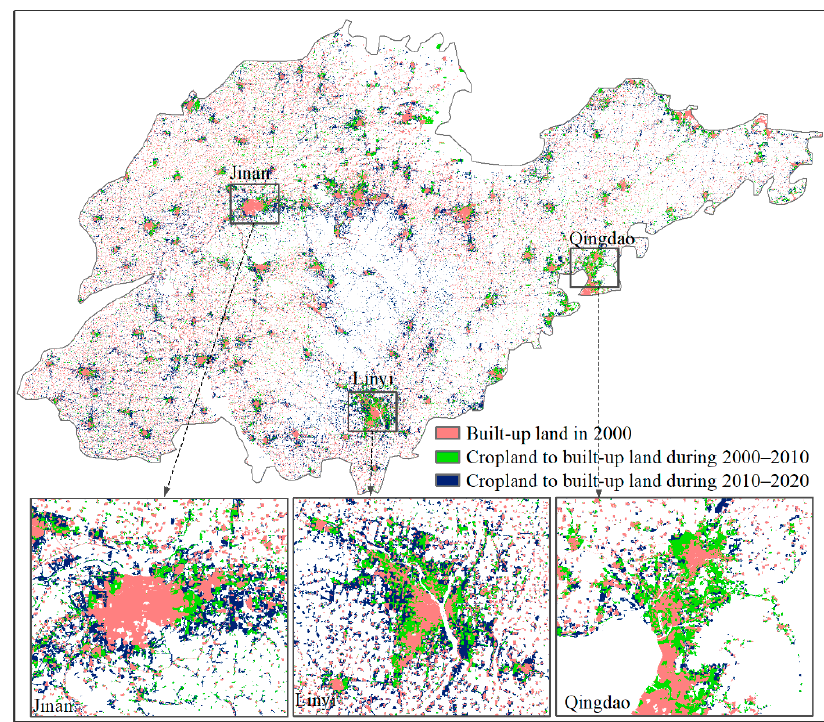
Figure 4. The spatial distribution of cropland occupied by built-up land during the period of 2000–2010 and 2010–2020.